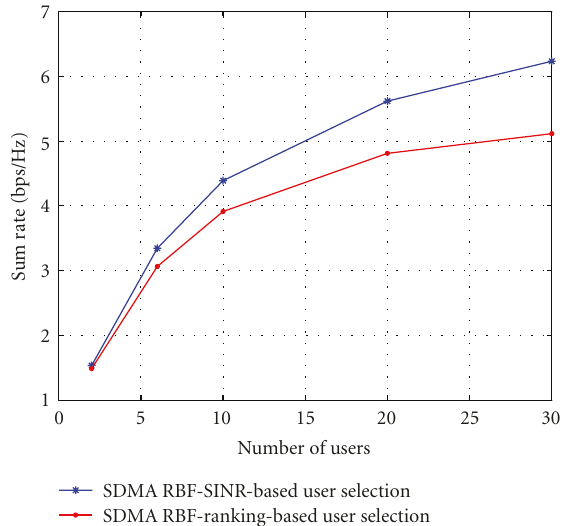
Figure 7: Sum rate as a function of users for multibeam RBF in a heterogeneous network in which users’ averagesignal-to-noise ratio (SNRs’) range from − 10dB to 30dB, M = 4 antennas, and W = 1000 slots. The system throughput reduction is due to the fact that ranking-based feedback does not always select the high SINR users as a means to restore temporal fairness among users with di ff erent pathlosses.